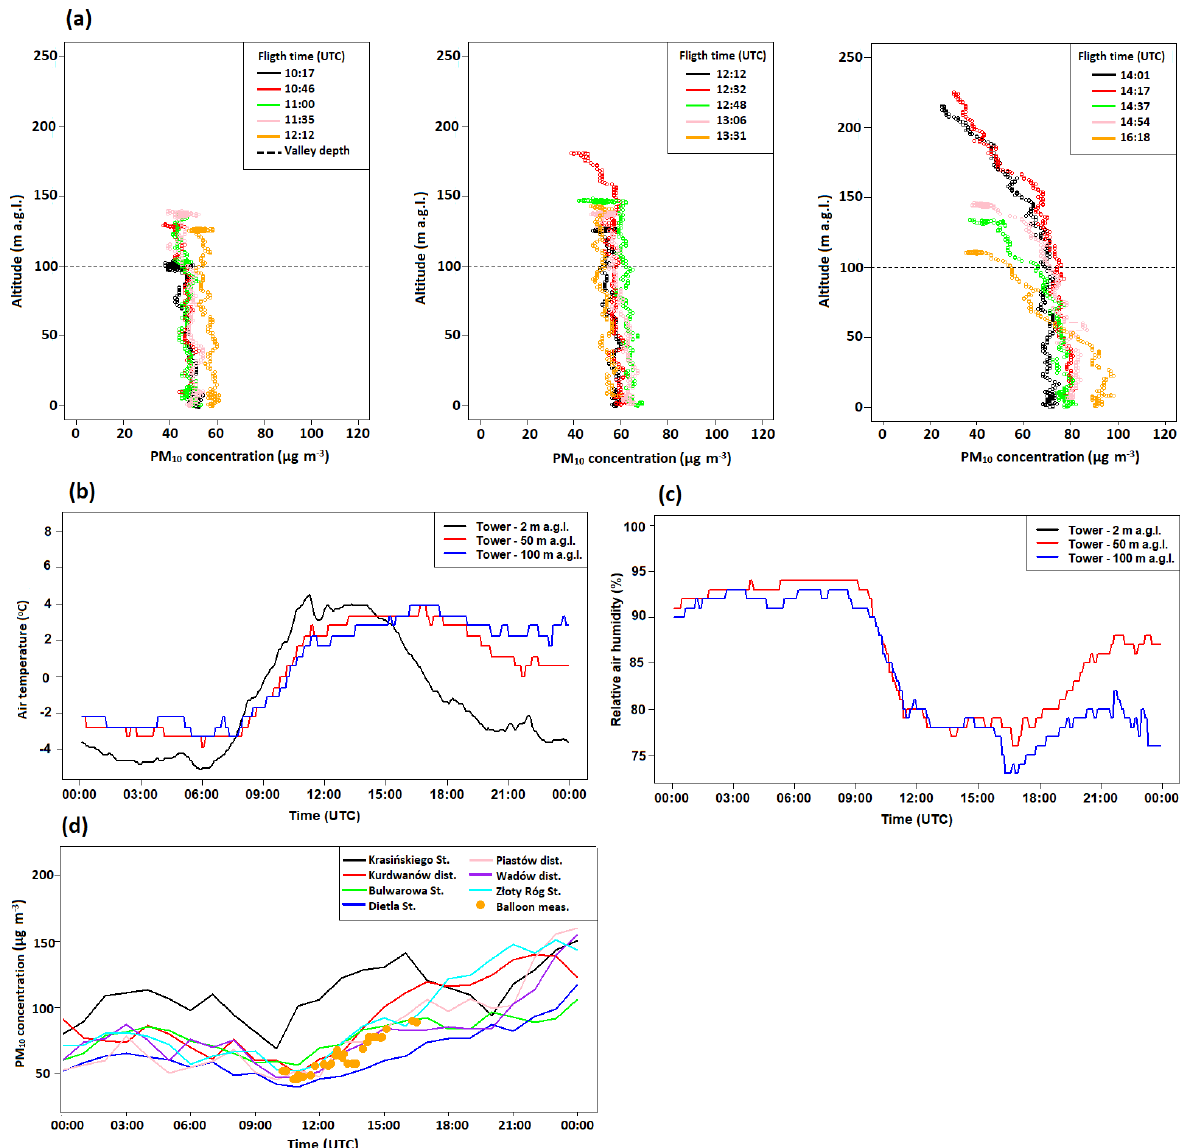
Figure 7. Vertical profiles of PM 10 concentration (a) , vertical profiles of air temperature (b) and (c) relative air humidity from the TV tower and (d) hourly concentration of PM 10 in air pollution from ground-level measurements during balloon soundings on 27 January 2020. Explanation: valley depth is the altitude of the hilltops surrounding the valley marked at 100ma.g.l. with a dashed line in (a)